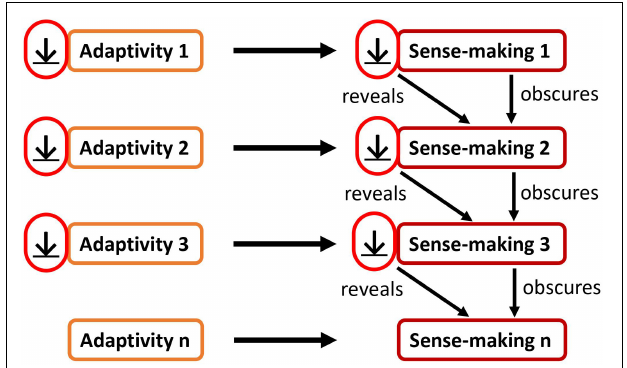
FIGURE 2 | The decrease of an adaptivity act decreases the respective sense-making process to which it gives rise; as a result, a subtler sense-making act becomes